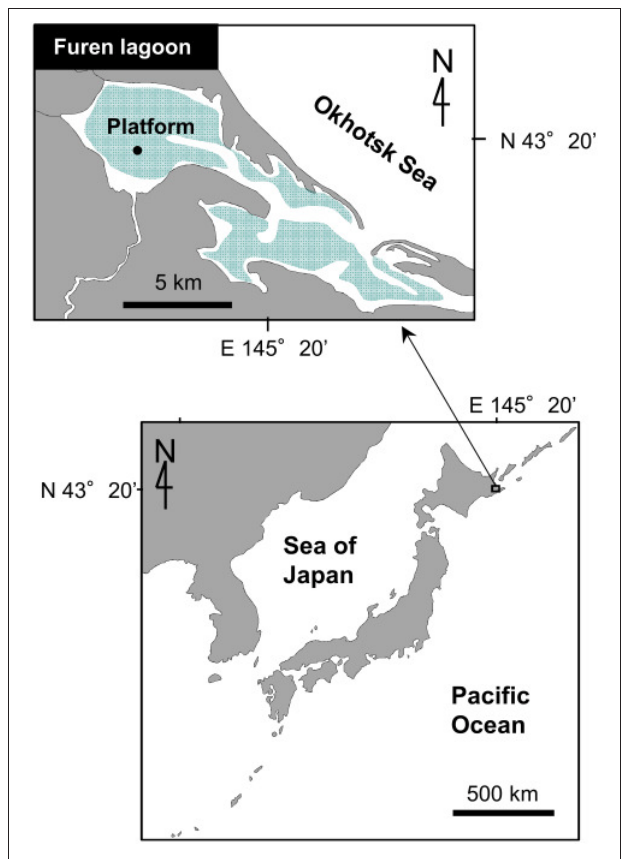
FIGURE 1 | Location of the measurement site (Furen Lagoon, Hokkaido, Japan). The lagoon is shallow (1–2m). Green area indicates seagrass meadows. Eddy covariance (EC) measurements were performed on the platform in